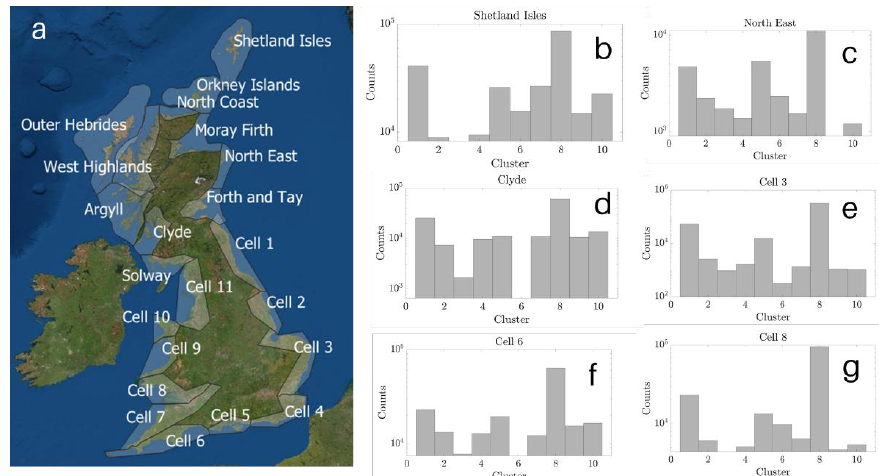
Figure 12. Example of the regional statistics that we extracted for the 22 regions into which we divided the GB coastline: ( a ) shows the region coverage; ( b – g ) show the counts of topographical cluster types for some regions (all other regions are shown in Supplementary Materials). Source of aerial imagery: Esri, Maxar, GeoEye, Earthstar Geographics, CNES / Airbus DS, USDA, USGS, AeroGRID, IGN, and the GIS User Community, v10.6.